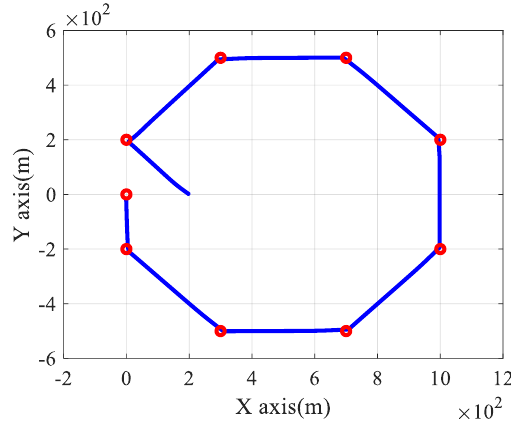
Figure 7. Waypoint-tracking result.